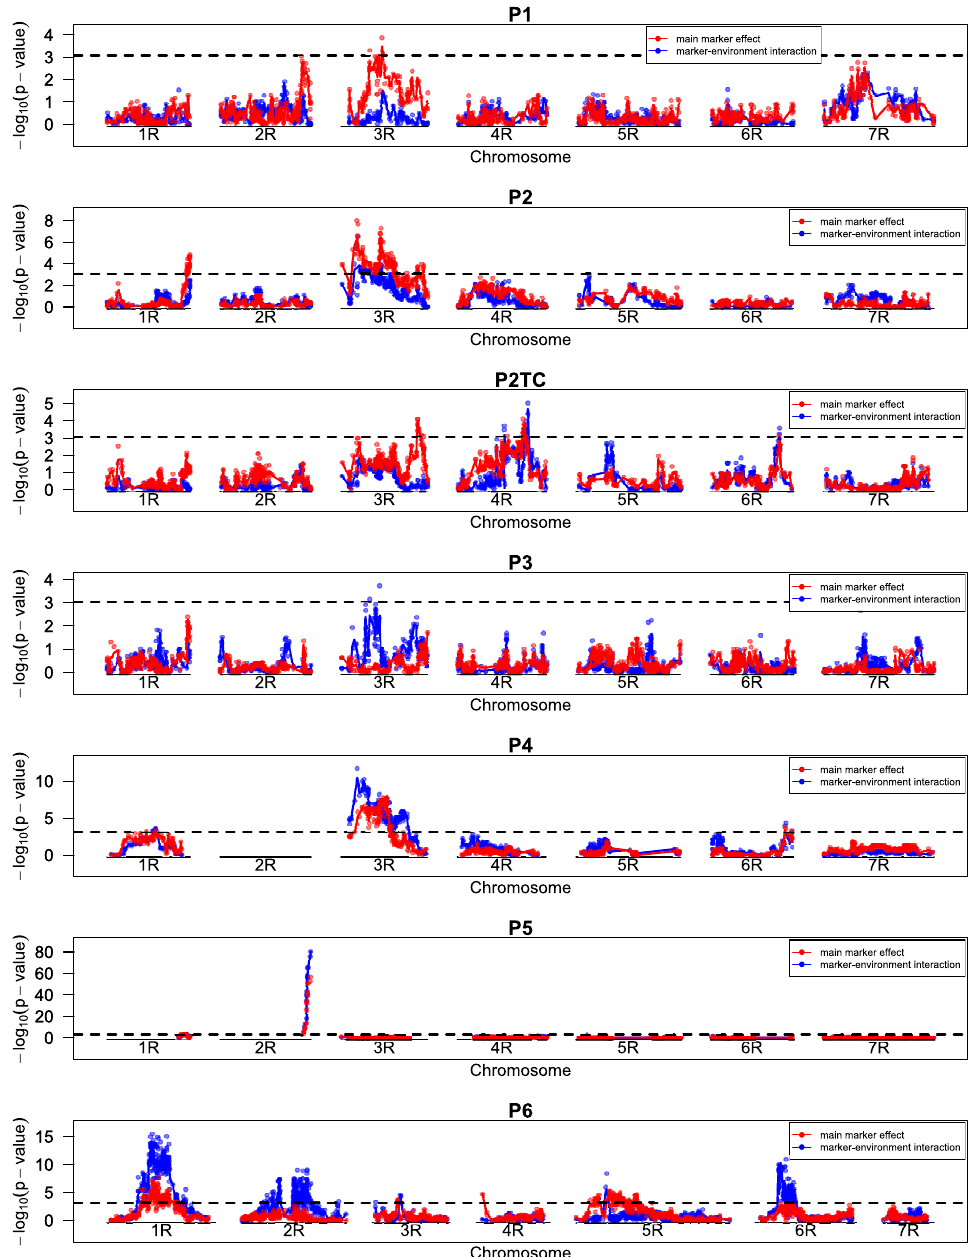
Figure 3. LOD ( − log 10 ( p -value)) profiles for populations P1–P6 and P2TC for stem rust. p -values of the single markers were calculated from a mixed linear model fitting main marker-effects (red) and marker-environment effects (blue) sequentially as fixed effects. Marker order of P1–P5 and P2TC was based on a consensus map from linkage maps of all populations (and populations from previous projects). Marker order of P6 was calculated separately as a different marker system was used. The dashed line shows the global significance threshold (alpha = 0.05) adjusted for multiple testing by the simpleM